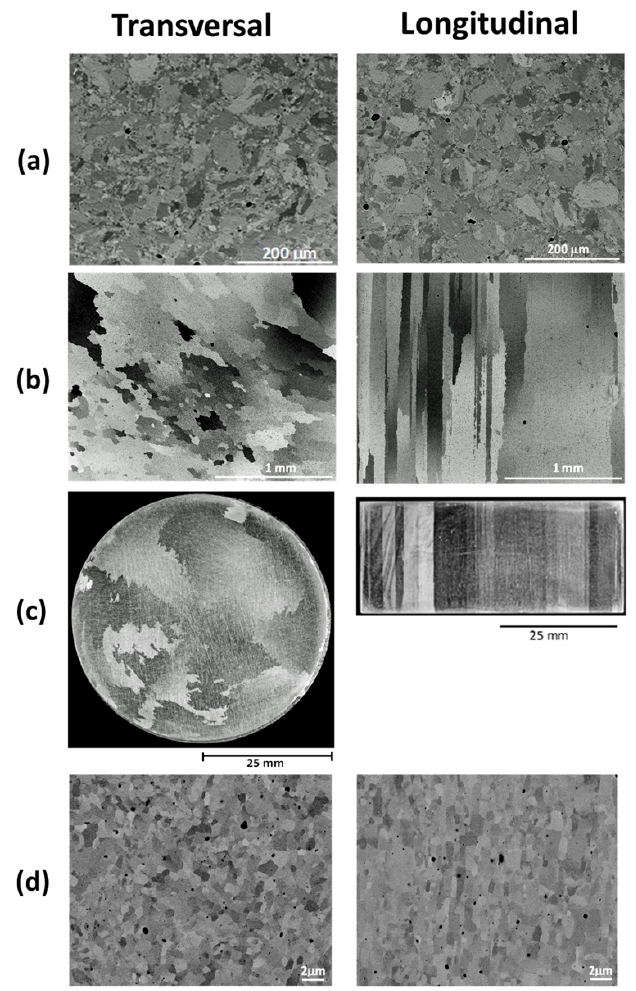
Figure 1. Scanning electron microscopy (SEM) and optical microscope images showing the microstructure of transverse (left) and longitudinal (right) cross sections of: ( a ) Random, ( b ) < 100 > , ( c ) < 111 > , ( d ) < 110 > processing conditions.